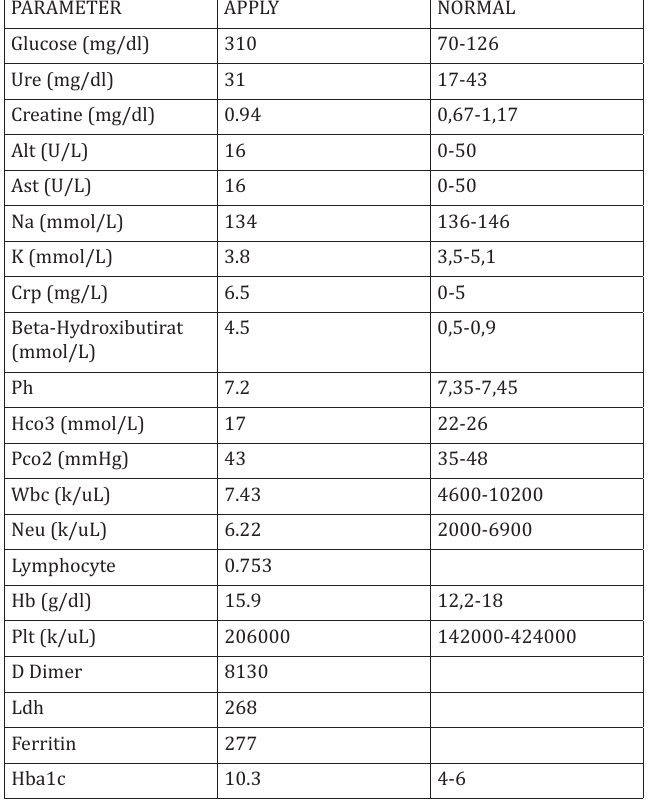
Laboratory findings